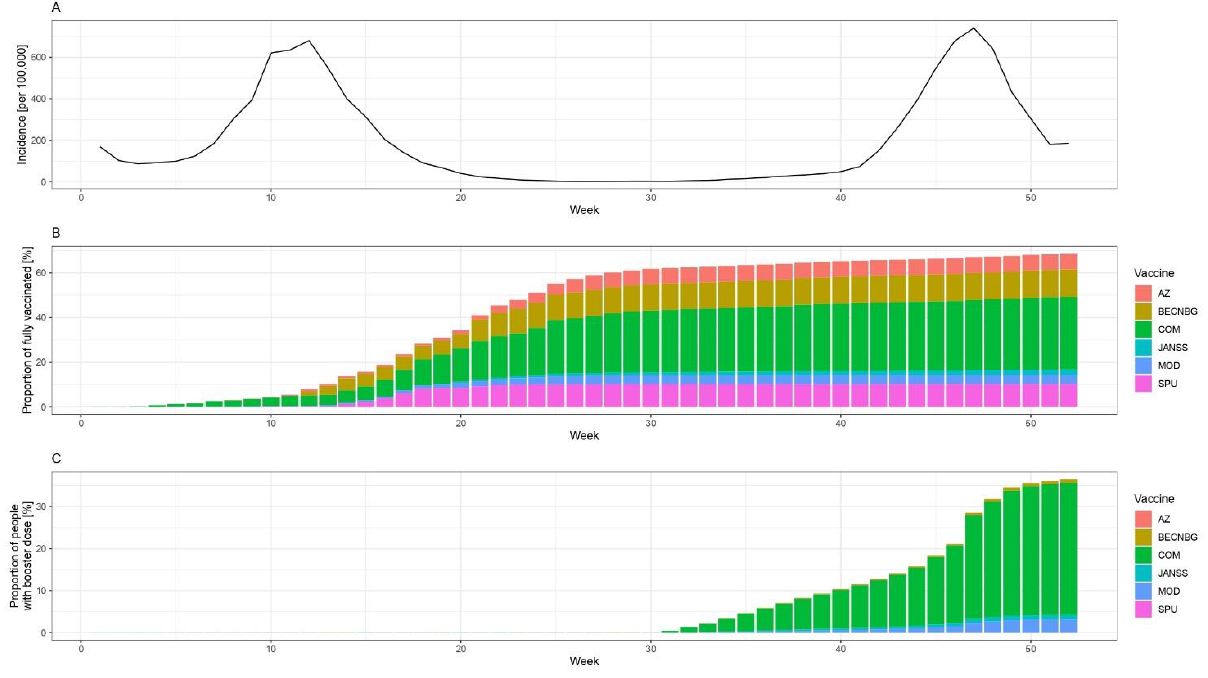
Figure 1. Epidemiological situation in Hungary (weekly number of reported cases per 100,000, panel A ), the proportion of fully vaccinated people by week and vaccine brand in Hungary (panel B ), and the proportion of people who received booster dose by the week and vaccine brand (panel C ) among those aged 12 or more, in 2021. Abbreviations: AZ: ChAdOx-1 (AstraZeneca, Cambridge, United Kingdom), BECNBG: BBIBP-CorV (Sinopharm, China National Biotec Group, Beijing Institute of Biological Products, Beijing, China), COM: Comirnaty (Pfizer/BioNTech, New York, USA), JANSS: Janssen (Johnson & Johnson, New Brunswick, NJ, USA), MOD: mRNA-1273 (Moderna, Massachusetts, MA, USA), SPU: Gam-COVID-Vac (Sputnik V, N.F. Gamaleya National Research Center for Epidemiology and Microbiology, Moscow, Russia)